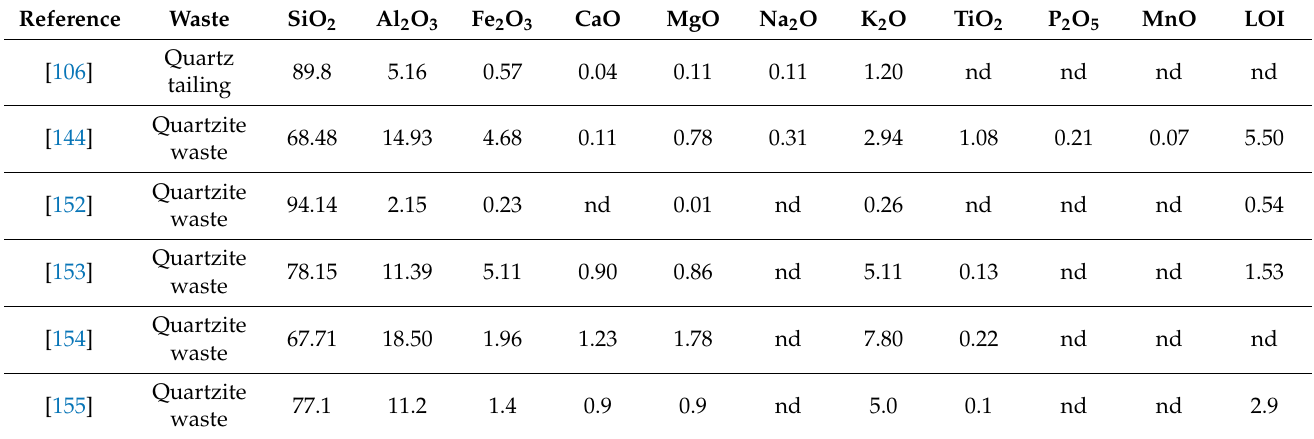
Table 23. Chemical composition (expressed wt.% oxide) of quartz and quartzite